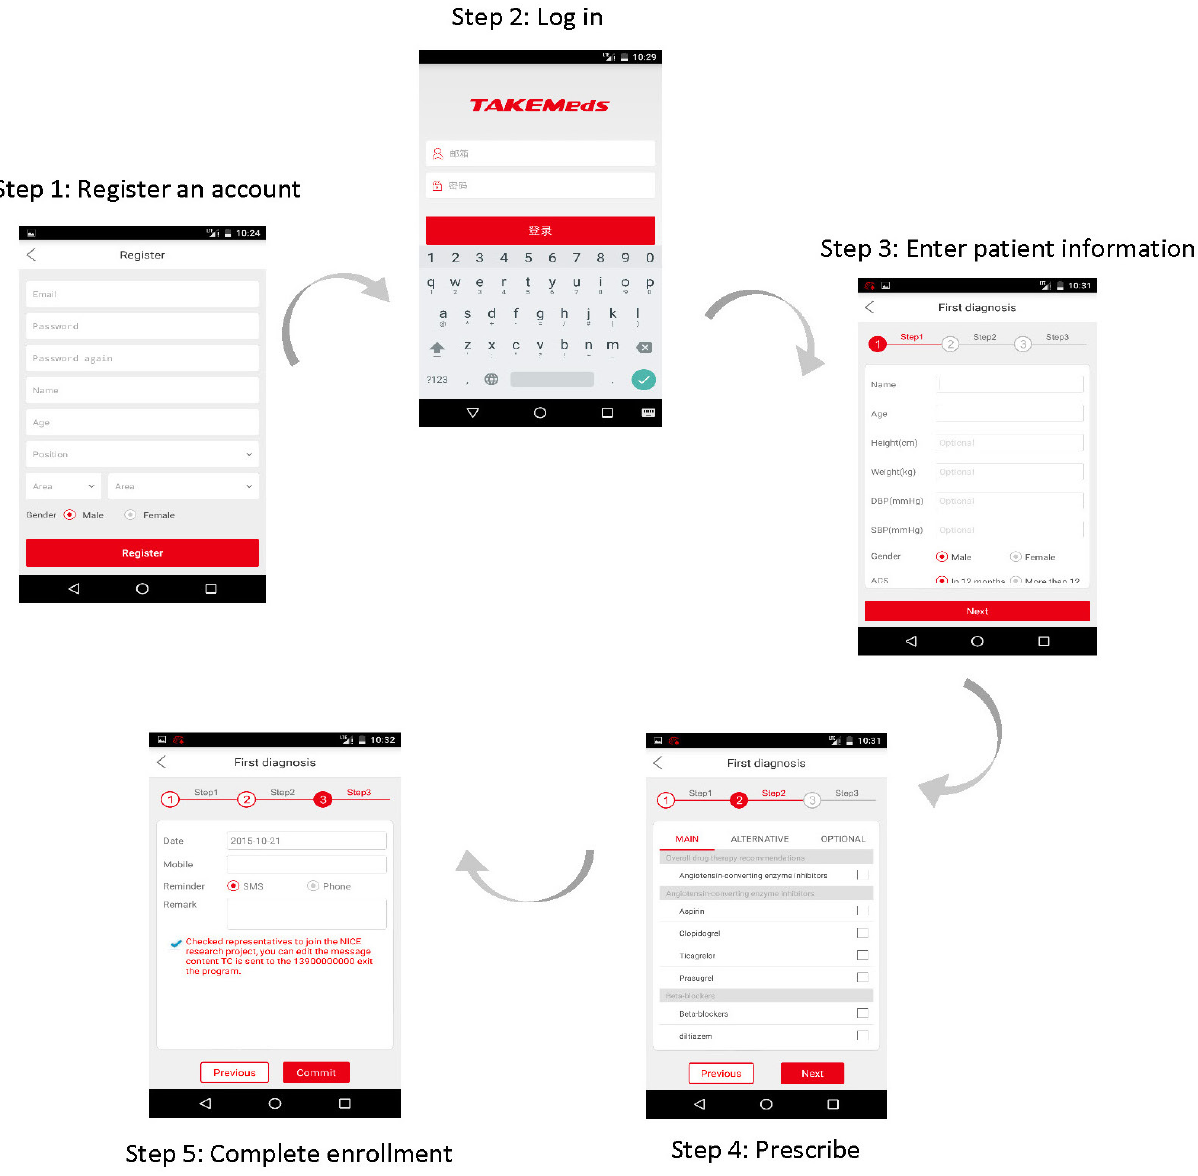
Figure 2. Flowchart of the Adherence and Knowledge Exchange heart disease medicines (TAKEmeds) app operational